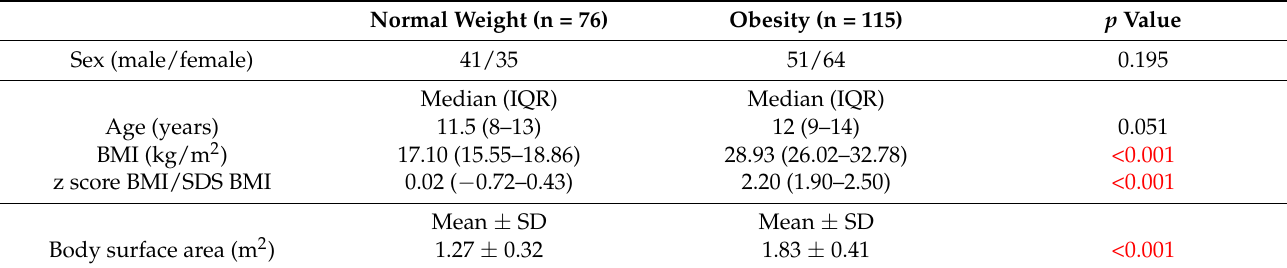
Table 1. Clinical phenotype of normal weight and obesity